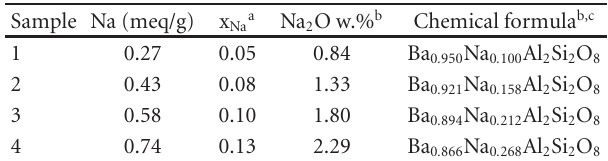
Table 2: Composition of the products. Sample Na (meq/g) x